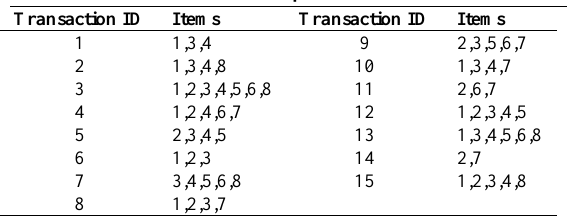
Table 2. Sample database.